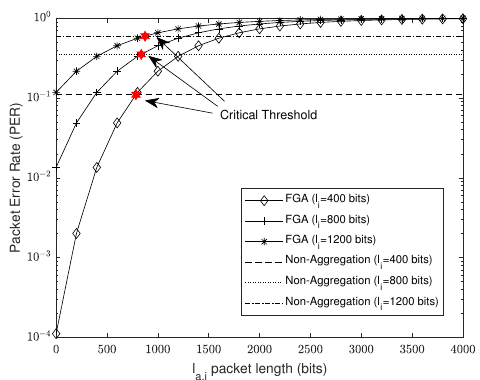
Figure 4. PER against aggregated packet size l a , i for different l i , where the critical thresholds can be evaluated based on Proposition 1.